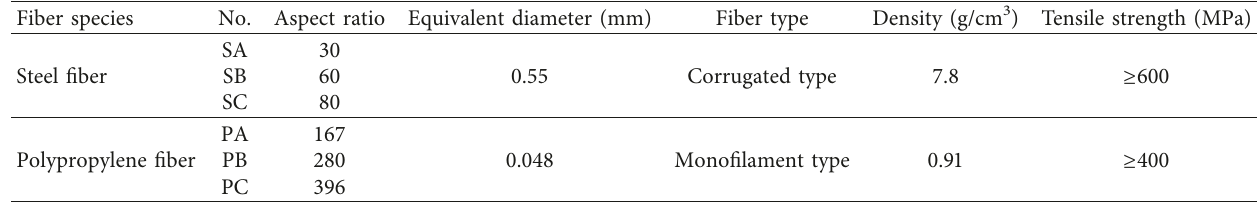
Table 2: Major properties of fibers.